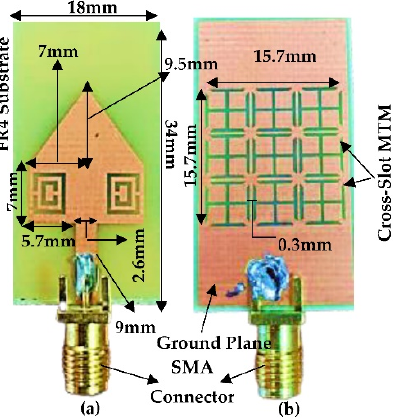
Figure 14. Fabricated structure of proposed antenna with complete ground plane ( a ) Top Layer ( b ) Bottom Layer.